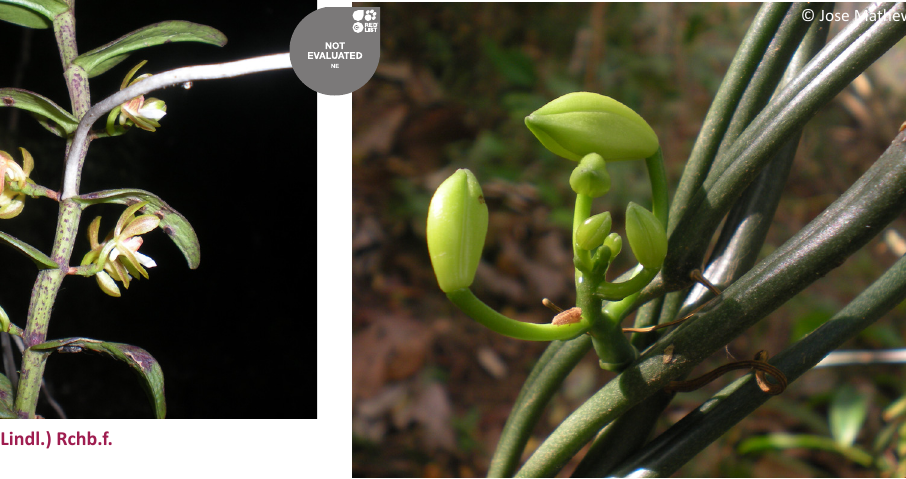
Image 6. Trias bonaccordensis C.S. Kumar